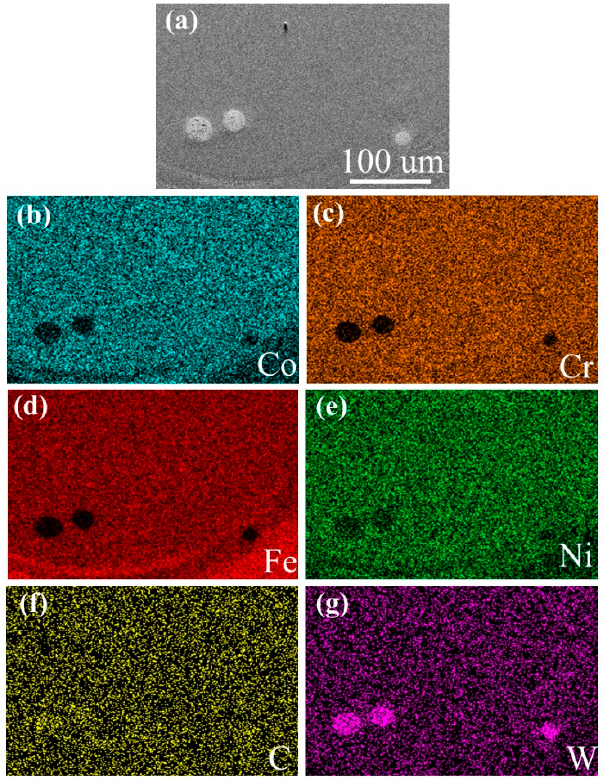
Figure 5. EDS mapping of HEA/WC composite coating of sample D around the WC particles. ( a ) SEM of the HEA/WC composite coating; ( b ) Co element distribution; ( c ) Cr element distribution; ( d ) Fe element distribution; ( e ) Ni element distribution; ( f ) C element distribution; ( g ) W element distribution.